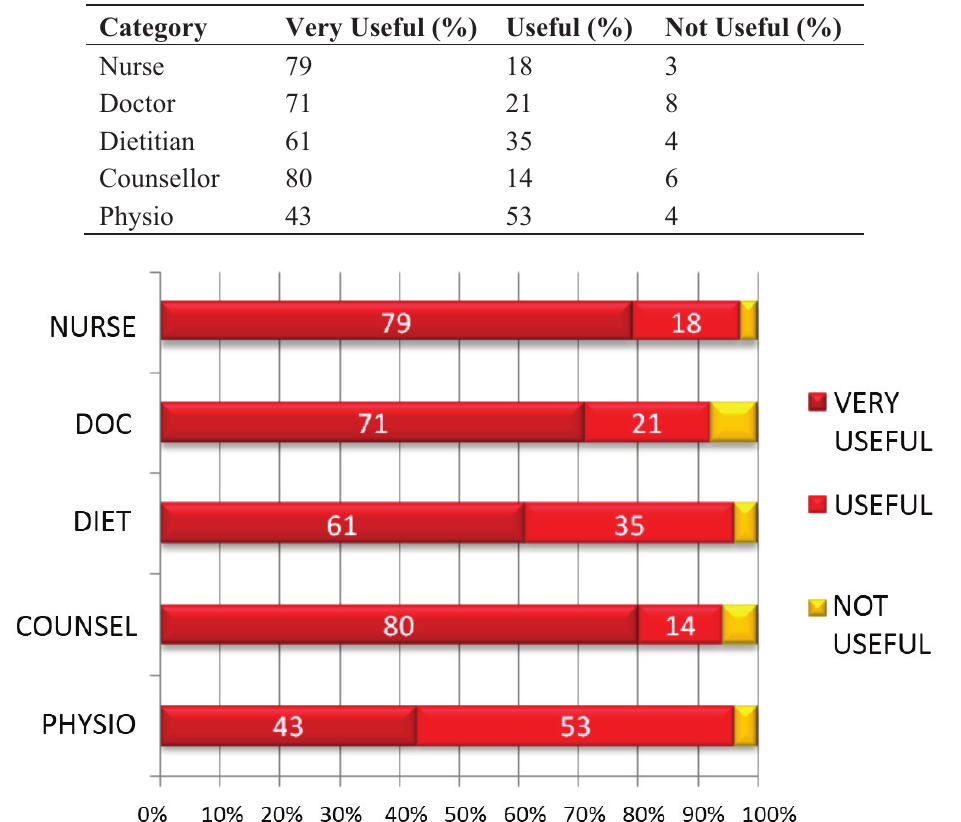
Figure 3. Percentage of respondents finding consultations with each healthcare professional very useful, useful and not